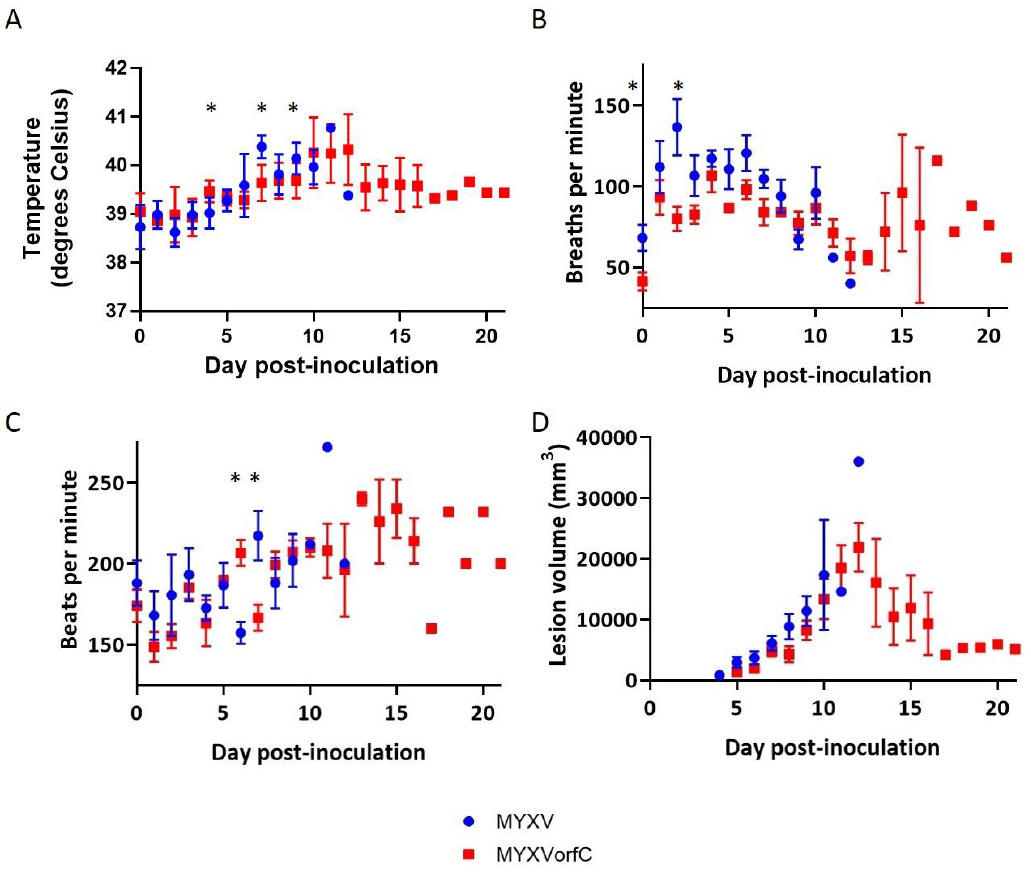
Figure 10. Average daily measurements during physical examination of rabbits infected with 50 pfu of MYXV or MYXVorfC ( n = 6 per group). Small, but statistically significant di ff erences were observed on a few days when average ( A ) body temperature, ( B ) respiratory rate, and ( C ) heart rate were compared. No significant di ff erences were observed when ( D ) average daily lesion volumes were calculated (error bars = SEM, * p -values < 0.046).